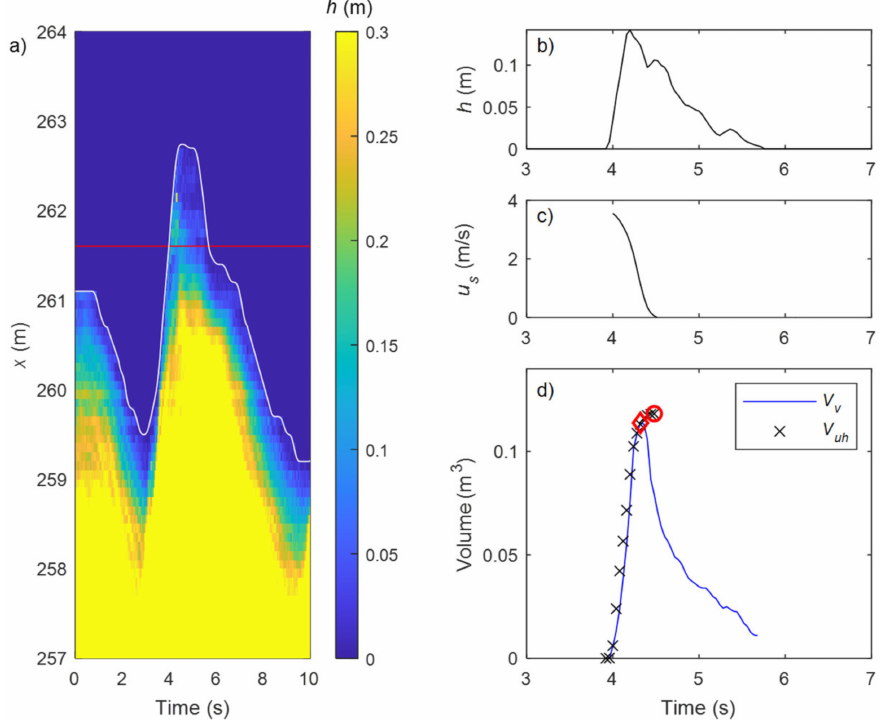
Figure 3. Example overtopping event. ( a ) Timestack of flow depths during an example overtopping event. The red line shows the cross-shore location of the revetment crest, x c and the solid white line indicates the shoreline position. ( b ) Time series of depth h at the revetment crest during the overtopping event. ( c ) Landward velocity of the shoreline. ( d ) Timeseries of overtopping volume using the peak volume ( V v ) and sum of positive discharge ( V uh ) methods. The red markers indicate the overtopping volume estimates V v,max = 0.087 m 3 (red diamond) and V uh,max = 0.096 m 3 (red circle) for this event. Note that V v is calculated relative to the bed elevation preceding the overtopping event and so does not return to zero in this case because the overtopping leads to minor bed